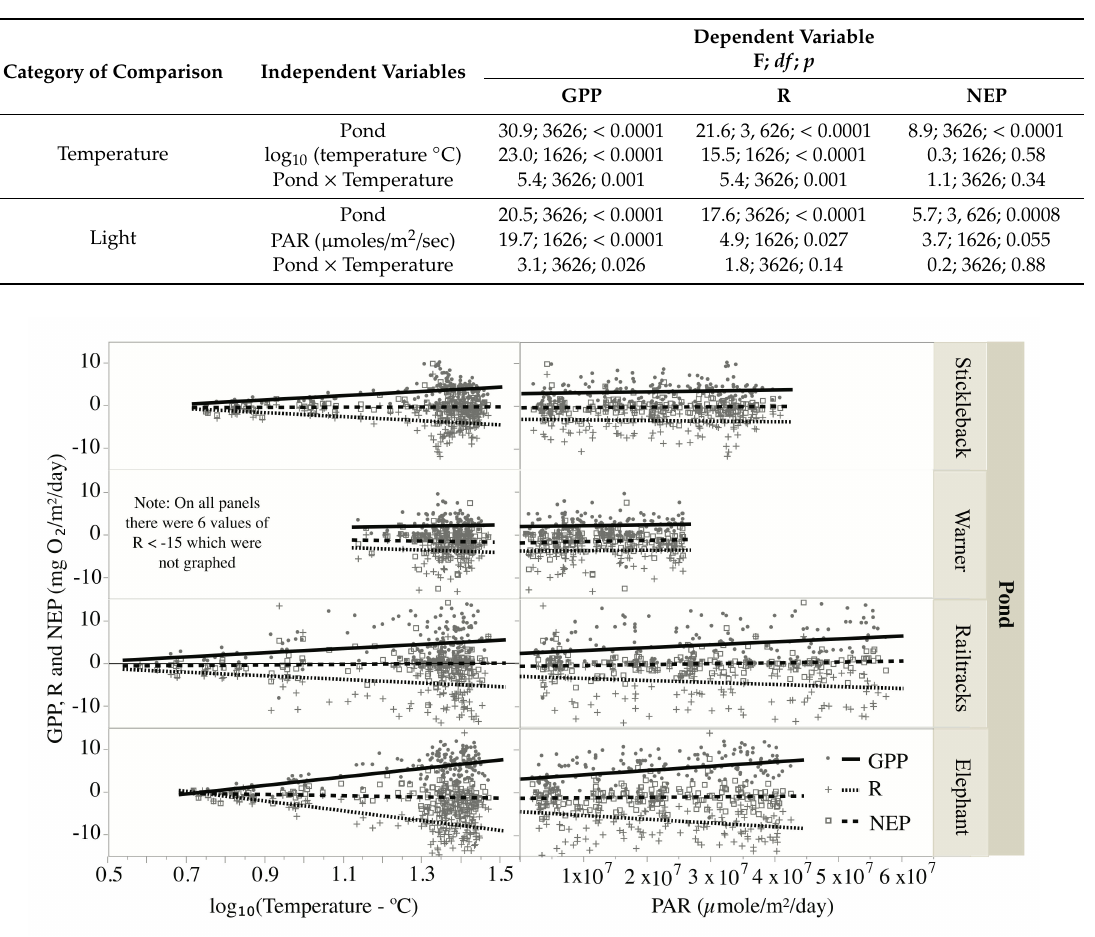
Table 4. ANCOVA results ( F -value, degrees of freedom and probability) for e ff ects of water temperature or light and pond on measures of ecosystem metabolism (GPP, R and NEP) for four ponds in east-central Minnesota, USA.